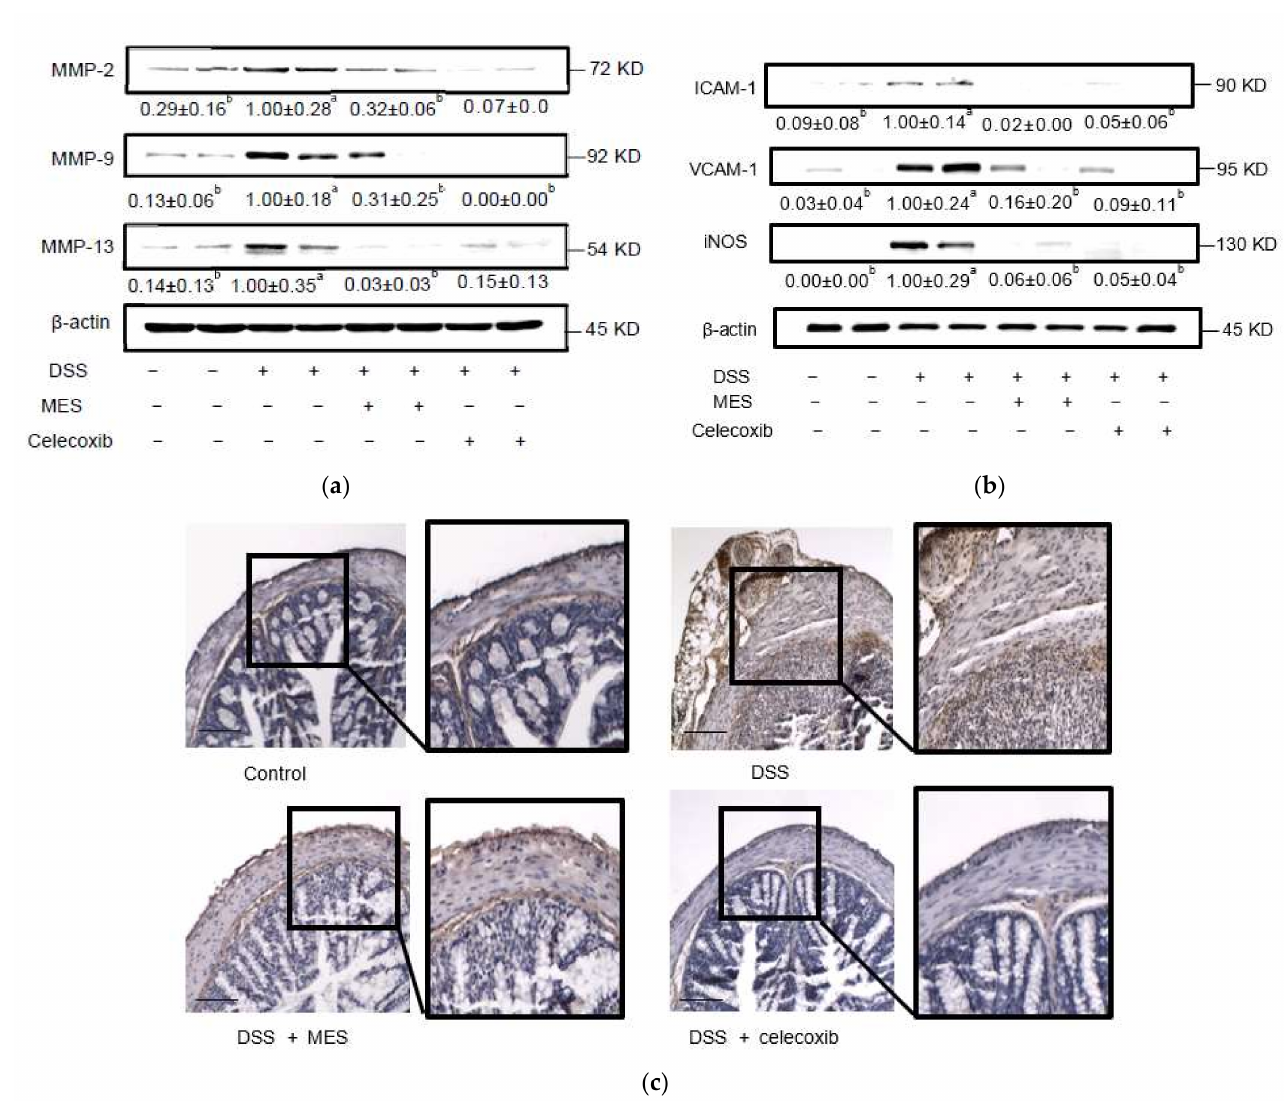
Figure 5. MES supplementation represses levels of inflammation-related proteins in colon of DSS- induced colitis mice. Total protein levels of ( a ) MMP-2, -9, and -13 and ( b ) ICAM-1, VCAM-1, and iNOS were determined by Western Blot. ( c ) Representative immunohistochemically stained slides with iNOS antibody in colon tissues (magnification, × 100 left), scale bar = 100 µ m. All data are expressed as mean ± SD. Bars with no common letters are significantly different ( p < 0.05). DSS: dextran sulfate sodium; MES: meroterpenoid-rich ethanoic extract of a brown algae, Sargassum macrocarpum ; MMP, matrix metalloproteinase; ICAM-1, intercellular adhesion molecule-1; VCAM-1: vascular cell adhesion molecule-1; iNOS, inducible nitric oxide